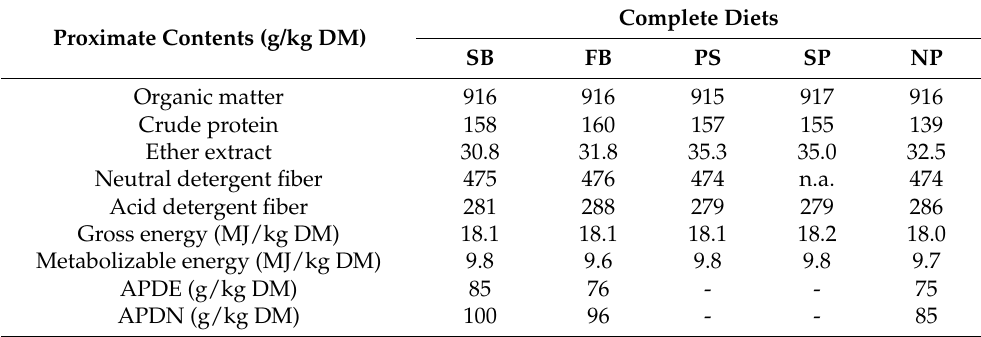
Table 3. Average proximate composition of complete experimental diets containing soybean meal (SB), faba beans (FB), pumpkin seed cake (PS), spirulina (SP), or no additional protein source (NP). Proximate Contents (g/kg